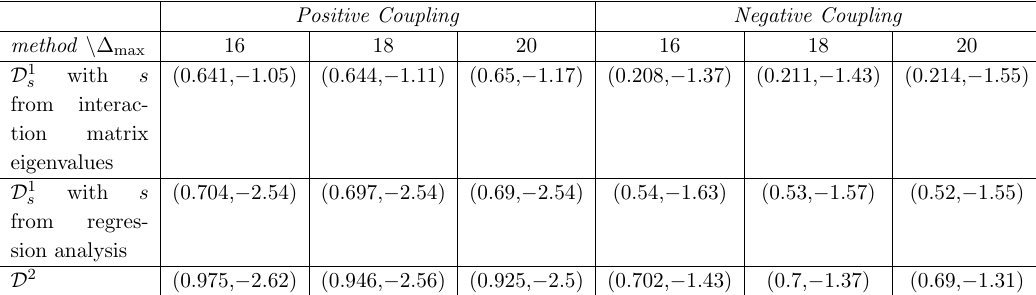
Table 4. Best (cid:12)ts for the leading IR exponent t for positive and negative coupling.